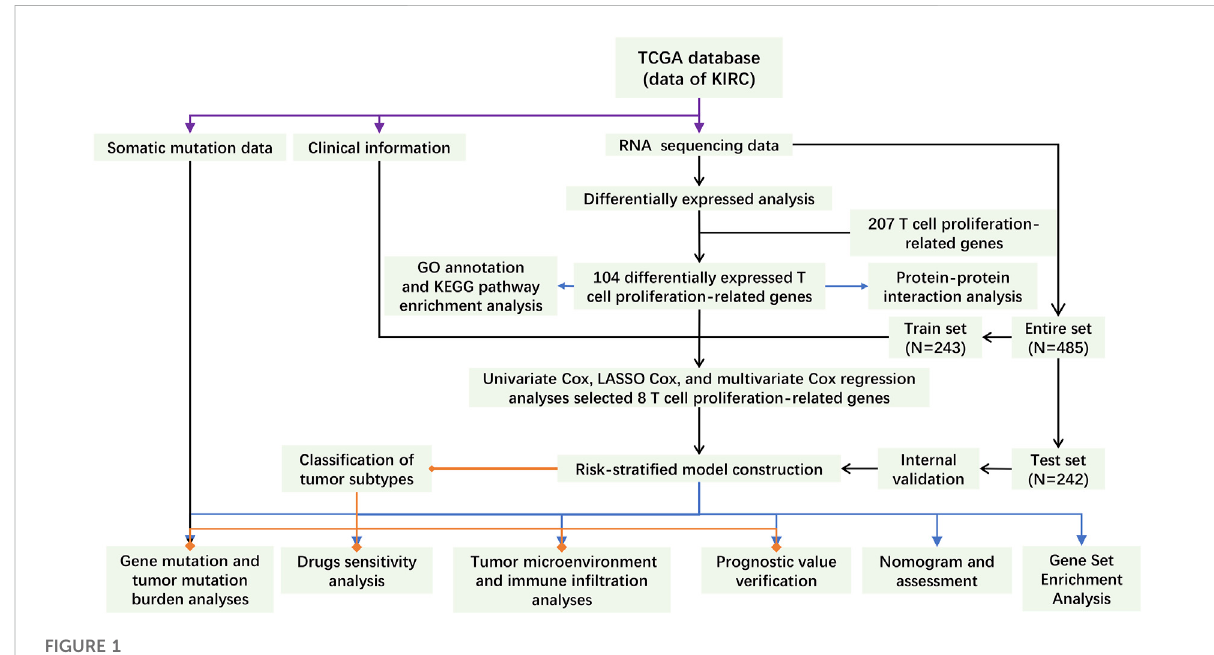
FIGURE 1 The fl owchart of this